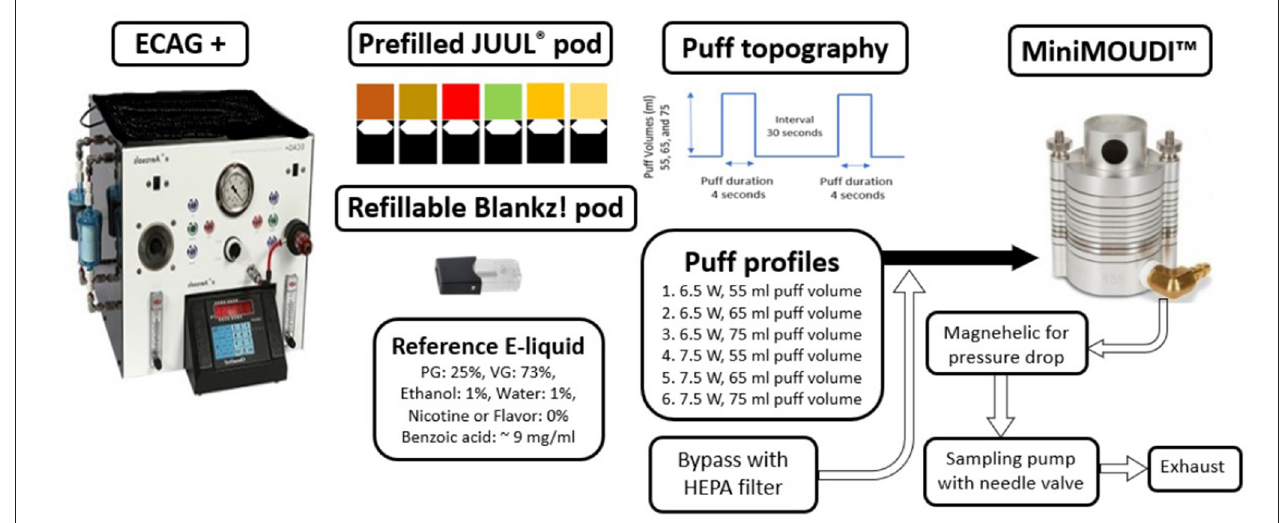
FIGURE 1 | Schematic of the experimental setup. ECAG + , Electronic cigarette aerosol generator plus. HEPA, High efficiency particular air.